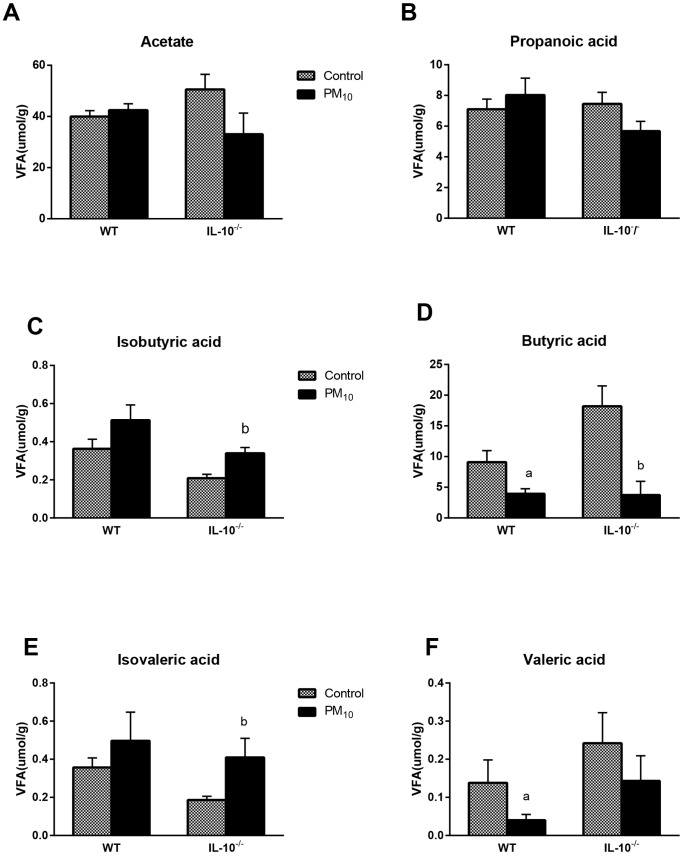
Short chain fatty acids in cecal contents.IL-10−/− mice exposed to PM10 showed a significant increase in isovaleric (F) and isobutyric (C) and a decrease in butyric acid (D). WT mice had a significant decrease in butyric acid (D) and valeric acid (F). Bars are mean ± SEM n = 6 for all groups a p<0.05 compared with WT control mice; bp<0.05 compared with IL-10−/− control mice.